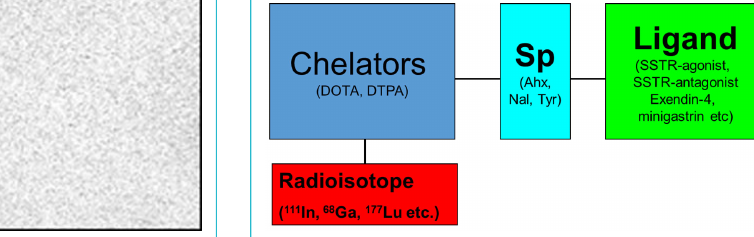
Figure 2: Structure of a peptide-receptor radionuclide for di- agnostic and therapeutic administration. A radiopeptide is pri- marily composed of the specific ligand (i.e., SSTR-agonist, SSTR- antagonist, exendin-4, minigastrin, etc.), a spacer (Ahx, Nal, Tyr) linking the ligand to a chelator (DOTA; DTPA) and the radioisotope for SPECT (i.e., 111 Ind:gamma-emitter) or PET (i.e., 68 Ga: positron emitter) or therapeutic use (i.e., 177 Lu: combined beta and gamma